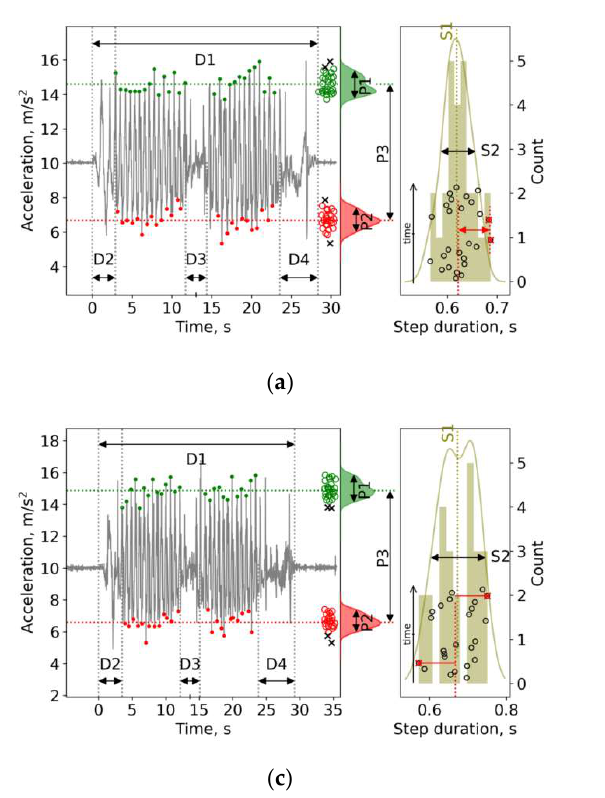
Figure 3. Individual plots for five separate DI sessions in three subjects. For details, see Figure 2: ( a ) Subject 1 before and ( b ) after the 1st DI; ( c ) Subject 1 before and ( d ) after the 7th DI; ( e ) Subject 2 before and ( f ) after the 5th DI; ( g ) Subject 2 before and ( h ) after the 4th DI; ( i ) Subject 3 before and ( j ) after the 7th DI. Unlike with a single DI session, a course of DI sessions exerted a significant influ- ence on a few gait parameters, namely, D4 and S5 (see, Table 2), which means that sub- jects with PD performed sitting down on a chair with turning (D4 phase) faster, and there were unusually long steps after a course of DI sessions. The individual plots of stepping are presented in Figure 4.